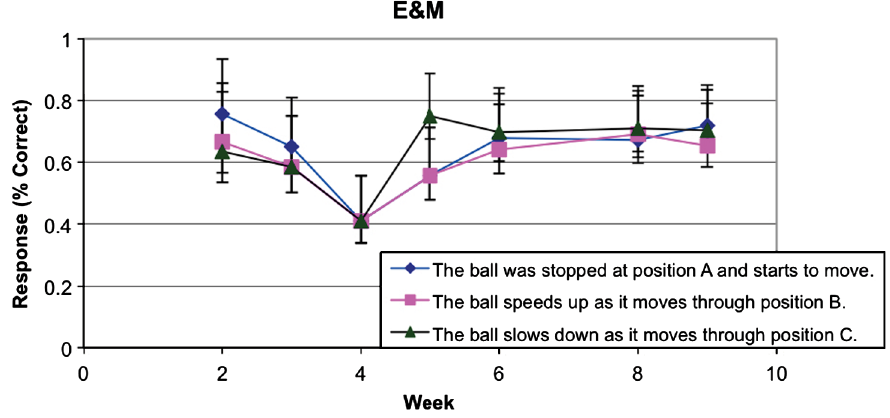
FIG. 6 (color online). Response curve for E&M. The response is mostly flat around the average of 66% with a measurable dip during week 4. This dip corresponds to the period of instruction in electric